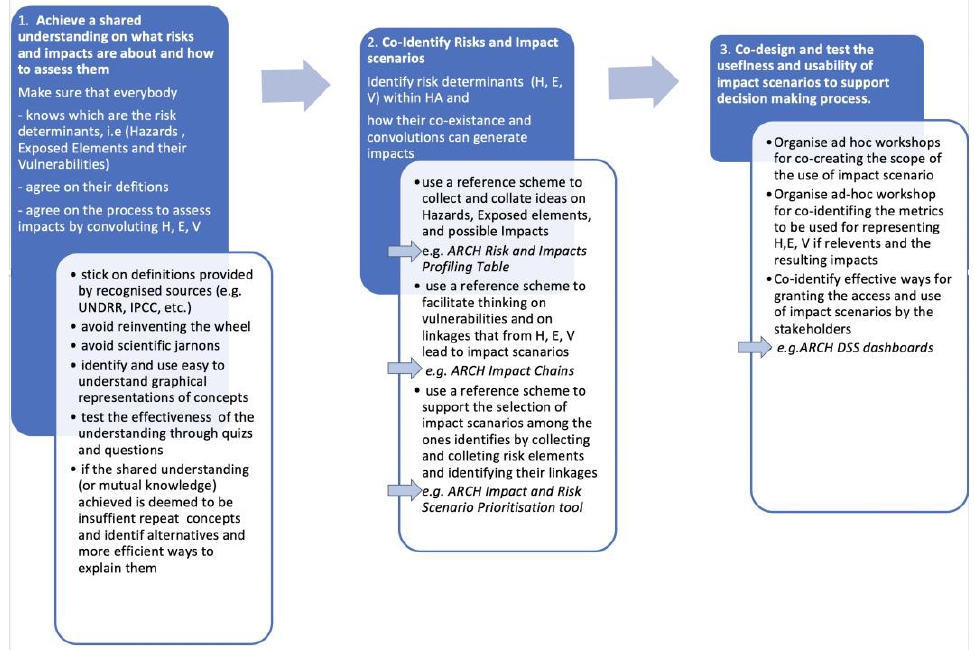
Figure 3. Schematic representation of the co-created impact and risk assessment process that has been originally defined as part of the ARCH project .